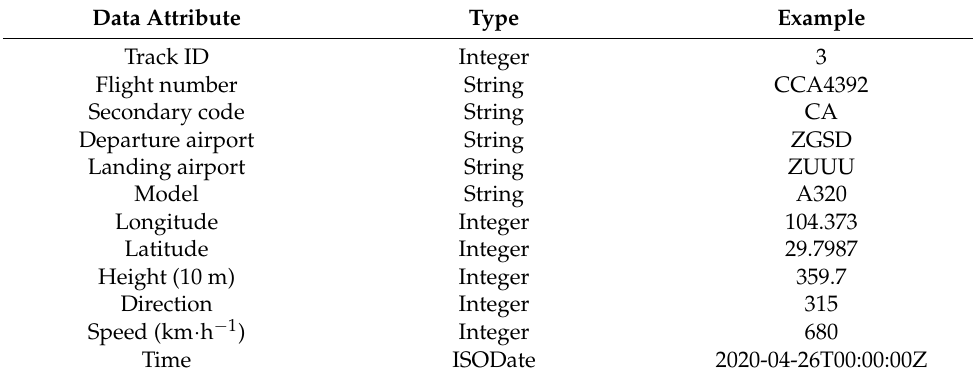
Table 5. ADS-B data structure and its example